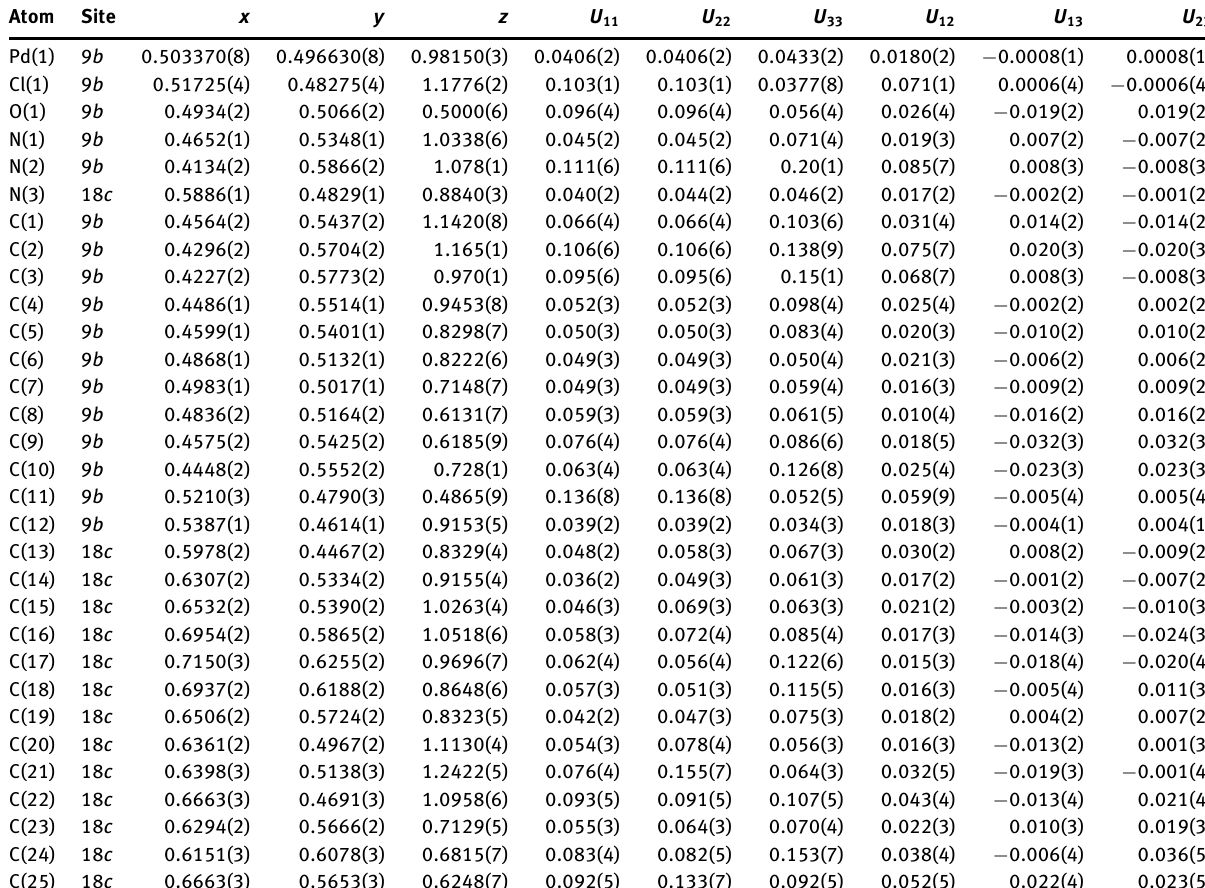
Table 3: Atomic displacement parameters (Å 2